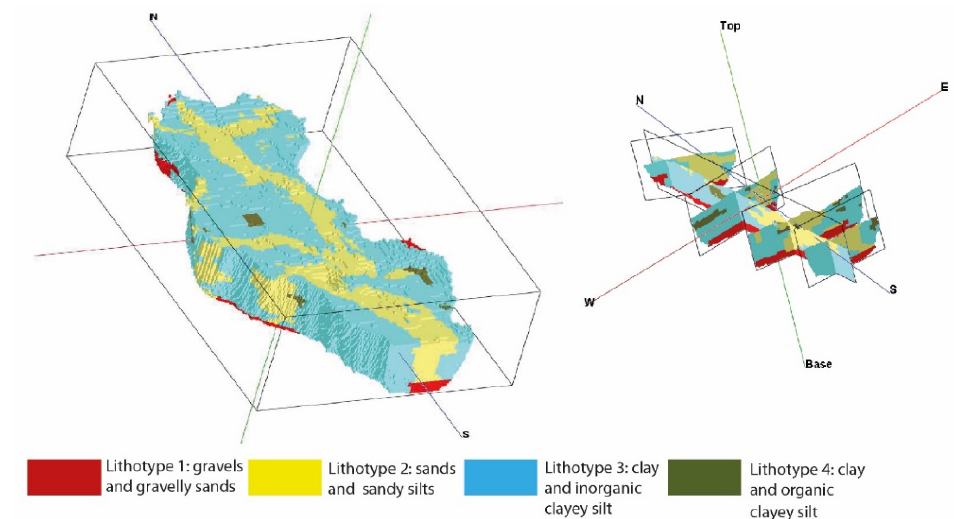
Figure 7. 3D model ( left side ) of the Tiber River depositional sequence and model cut into cross sections ( right side ). Table 4. List of piezometer types, monitored complex, and depth of the screened interval or monitor- ing